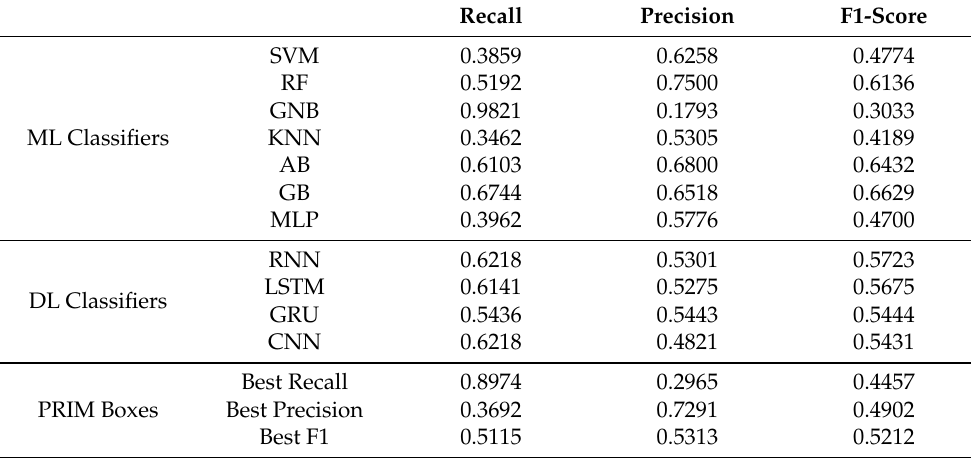
Table A1. Test results for all the classification methods evaluated, considering a time prediction horizon of +3